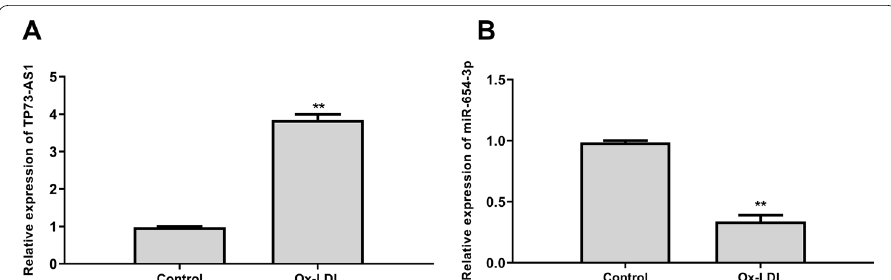
Fig. 1 TP73-AS1 was upregulated and miR-654-3p was downregulated in ox-LDL-treated endothelial cells. The figure shows the levels of TP73-AS1 ( A ) and miR-654-3p ( B ) detected by qRT-PCR in HAECs treated with or without 50 μg/ml ox-LDL for 24 h. **P <